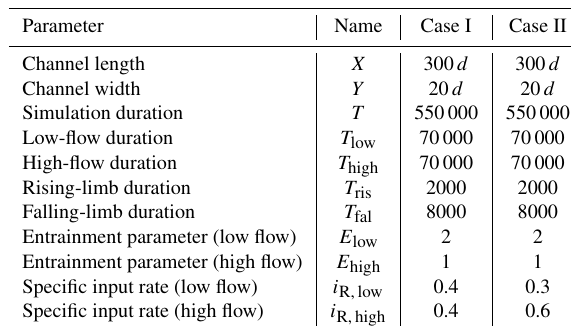
Table 2. Values of the parameters used in the unsteady